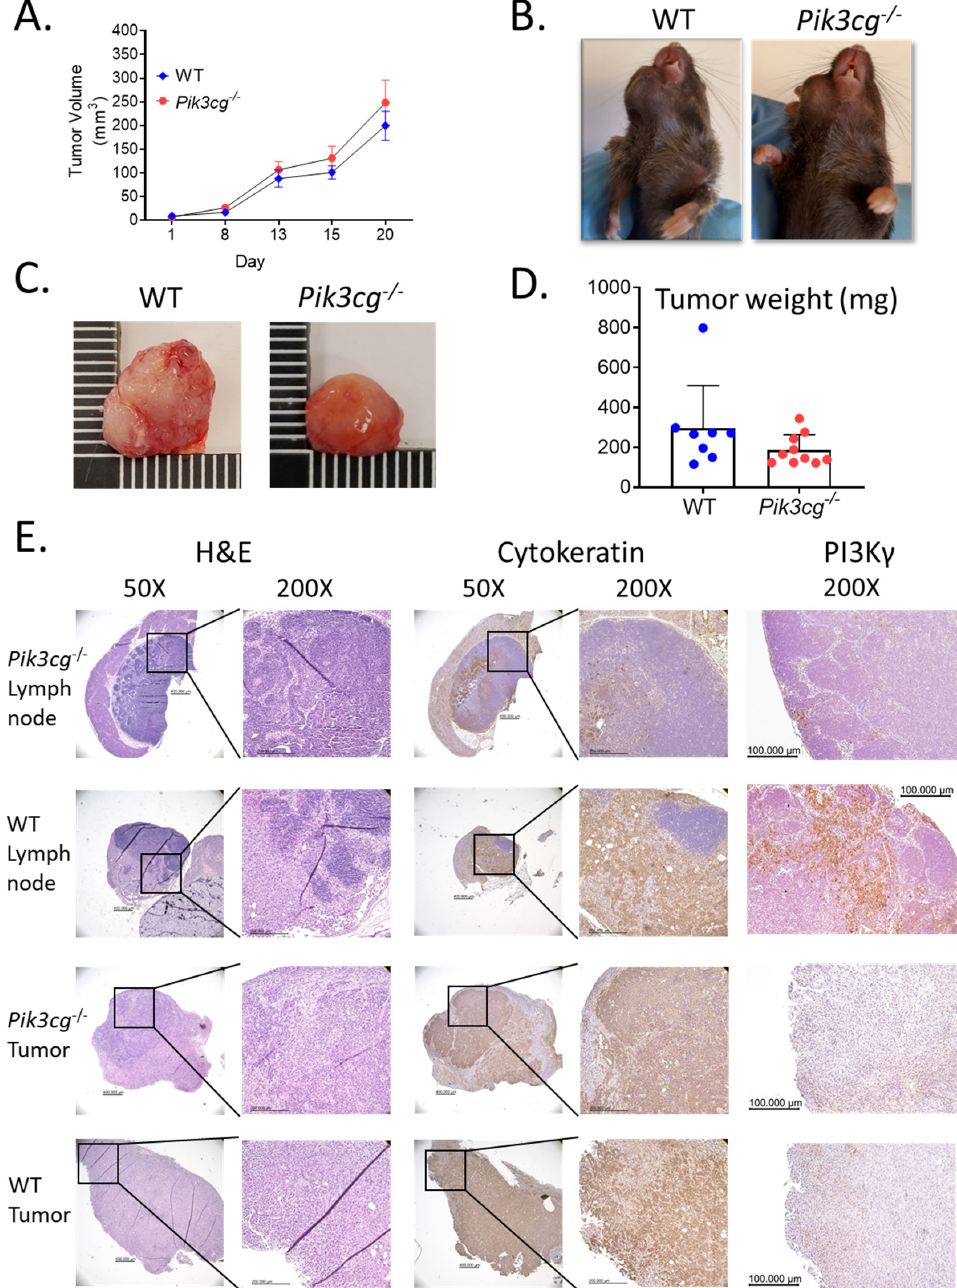
Figure 1. Host PI3K p110 γ inhibition does not have a significant effect on tumor growth or metastasis in mice injected with MOC2 oral cells. ( A ) Tumor volume in WT and Pik3cg − / − mice over the duration of the experiment. ( B ) Images of WT and Pik3cg - mice. Tumors were located on the right buccal side of the mice. ( C ) Images of whole tumors excised from experimental mice at terminal sacrifice. ( D ) Tumor weights were taken from whole tumors removed at terminal sacrifice. ( E ) Representative hematoxylin and eosin and immunohistological images of lymph node and tumor sections from tumor- bearing WT and Pik3cg − / − mice stained with AE1/3 pan-cytokeratin or PI3K p110 γ antibodies and counterstained with hematoxylin at 50 × and 200 × . Lymph node sections demonstrate regions stained positive for pan-cytokeratin, indicative of regional